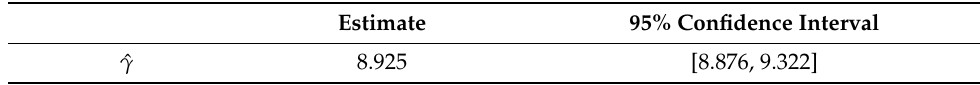
Table 4. Threshold estimates.